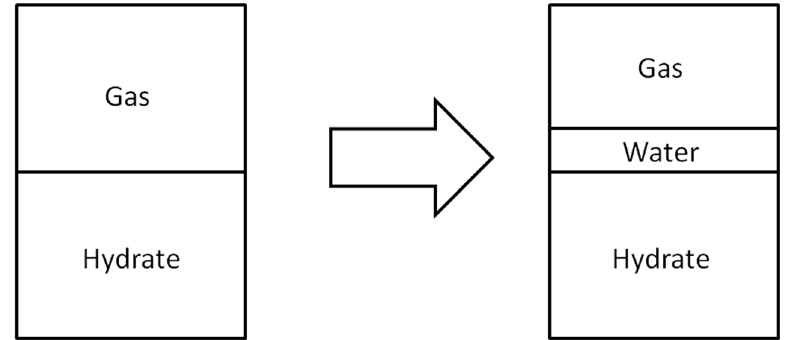
Figure 2. Schematic illustration of change in the interfacial area upon